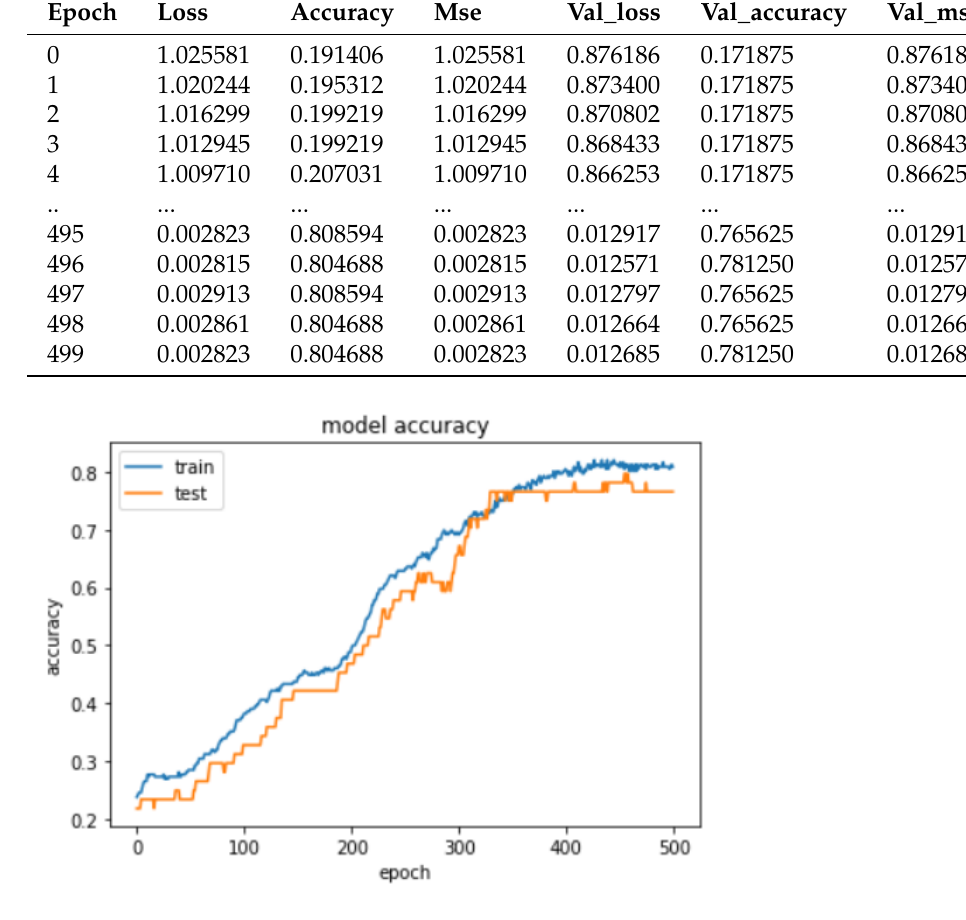
Figure 8. RBFNN accuracy curve.